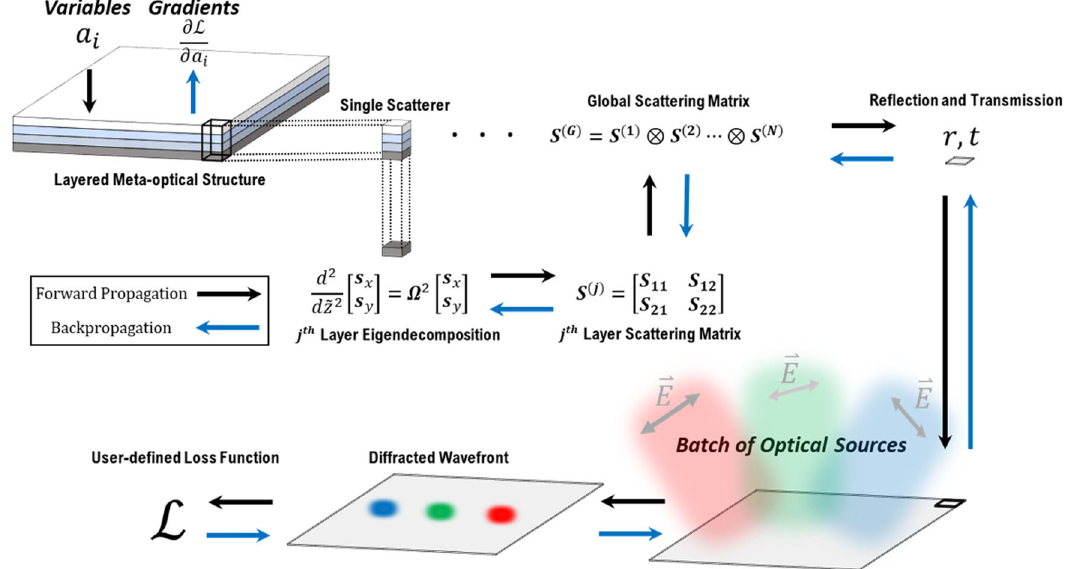
Fig. 1 Meta-optical computational graph schematic. Our framework treats a photonics problem like a neural network, where structural variables a i are * Þ are a batch of optical sources, and the user-de fi ned loss trainable weights that determine the structure of a layered meta-optical element, inputs ð E function L ð Þ captures the desired performance of the device. A sequence of differentiable tensor operations acting on the structural variables a i forward propagate (black arrows) data through the network, solving the eigenproblem posed by the matrix wave equation in which Ω 2 is a block matrix depending on the layer properties and wavevector expansions, ~ z is the normalized coordinate along the layer thickness direction, and s x and s y are the Fourier domain electric fi eld coef fi cients for x and y . This is performed for each layer, the number N of which is determined by the user and dictates the range of j , which we use here to denote the j th layer. The solved eigenequation for each layer enables us to calculate the scattering matrix S ( j ) for the j th layer, where the S 11 , S 12 , S 21 , and S 22 elements denote the standard scattering matrix components for characterizing ingoing and outgoing fi elds. The results of these separate layer scattering matrices, going up through the N th layer, are all combined via a Redheffer star product to form S ( G ) , where the G superscript denotes that this is the global scattering matrix of the full system. From S ( G ) , the re fl ection ( r ) and transmission ( t ) coef fi cients are determined, which then constitute the * electric fi elds to be diffracted in combination with the inputs E . Acting upon this batch of input optical sources with varying wavelength, wavevector, and polarization, the data is fi nally passed to the scalar, user-de fi ned loss function L ð Þ that is to be minimized. Data is then backpropagated (blue arrows) to enable computation of gradients ∂ L ∂ a to update the meta-optical i